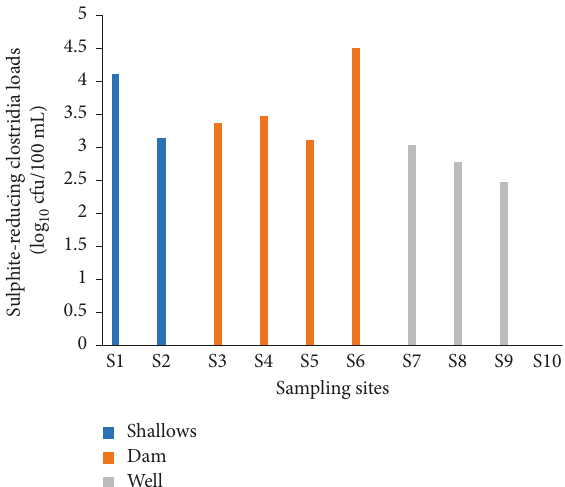
Figure 4: Sulphite-reducing clostridia counts in irrigation